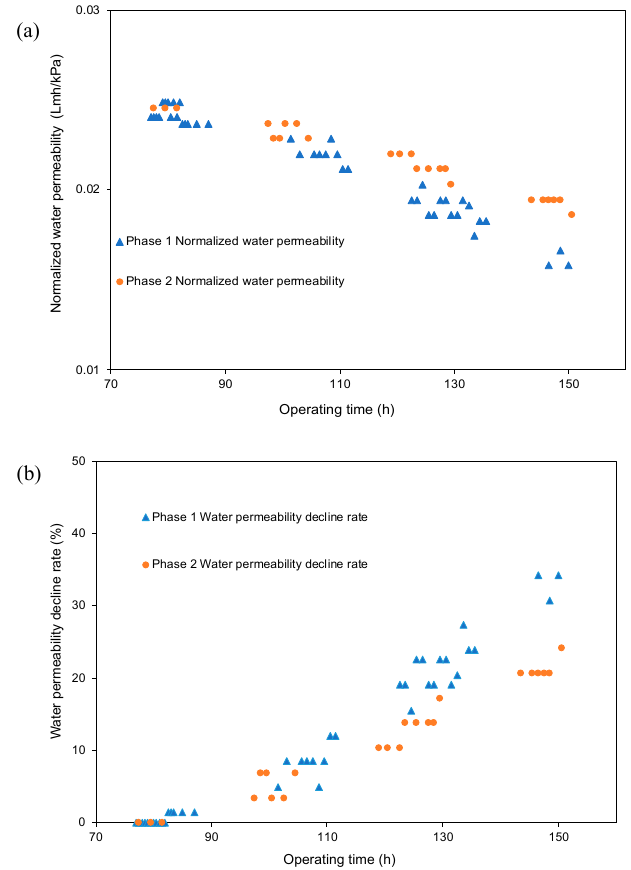
Figure 3. ( a ) Comparison of normalized water permeability, ( b ) Comparison of water permeability decline rate from 77 h (water recovery reached 50%) to 150 h of desalination, with (Phase 2) and without (Phase 1) HydroFLOW